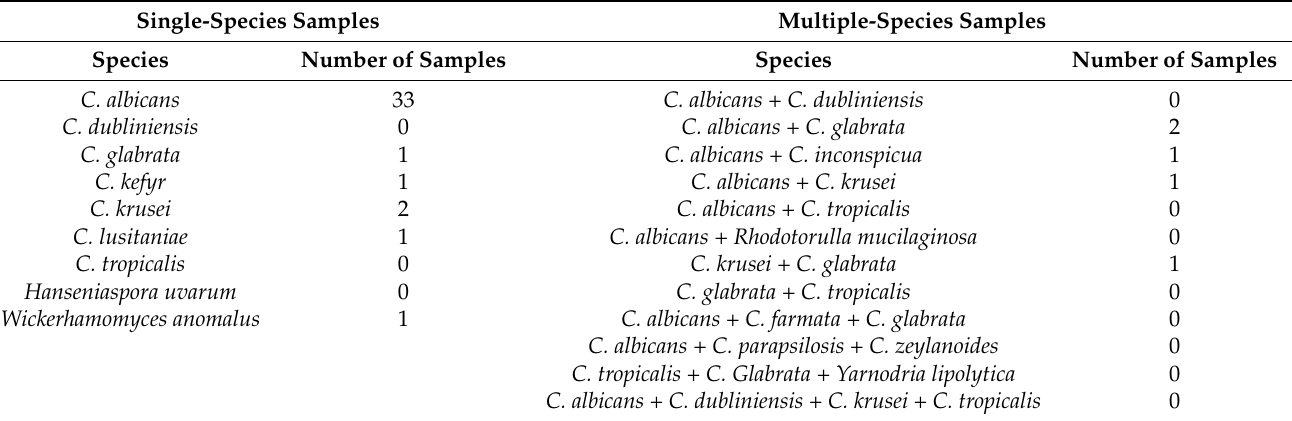
Table 2. Cultured species of fungi in samples taken from the test group.